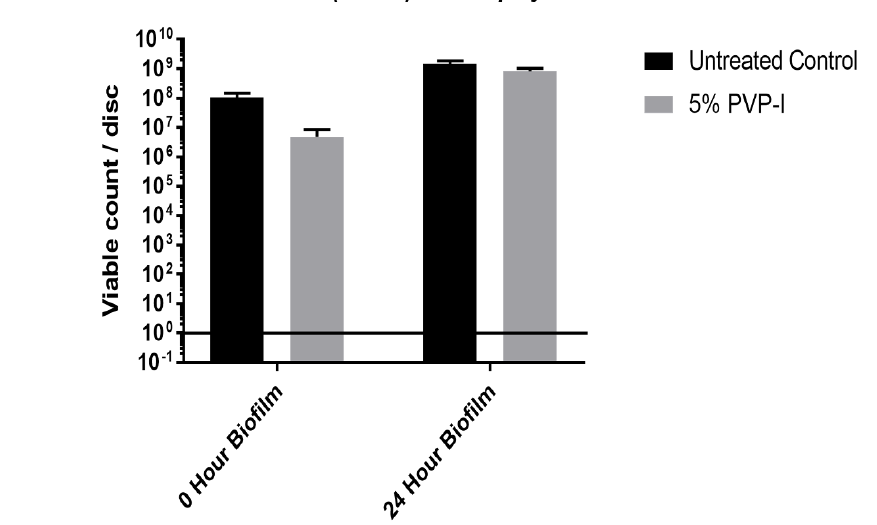
Figure 5. S. aureus that remained on discs quantified by CFU assay after treatment with 5% PVP-I, for both a zero time and a 24 h biofilm.